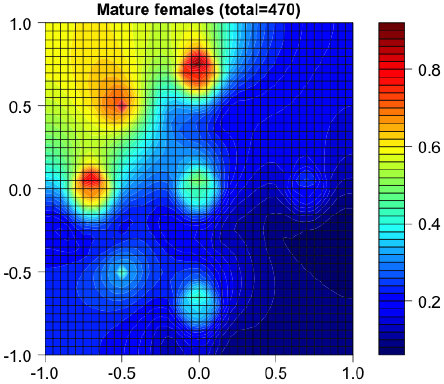
Mature Females distribution with North wind, and weekly releases of 1000 sterile males, near the North breading sites, from the 20th simulation day.